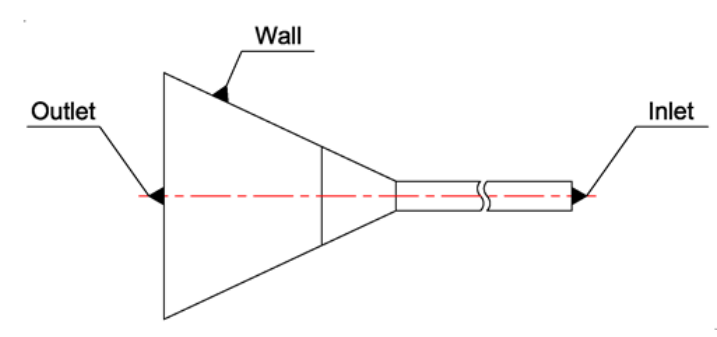
Figure 2. Schematic diagram of boundary condition. Table 2. Boundary conditions.